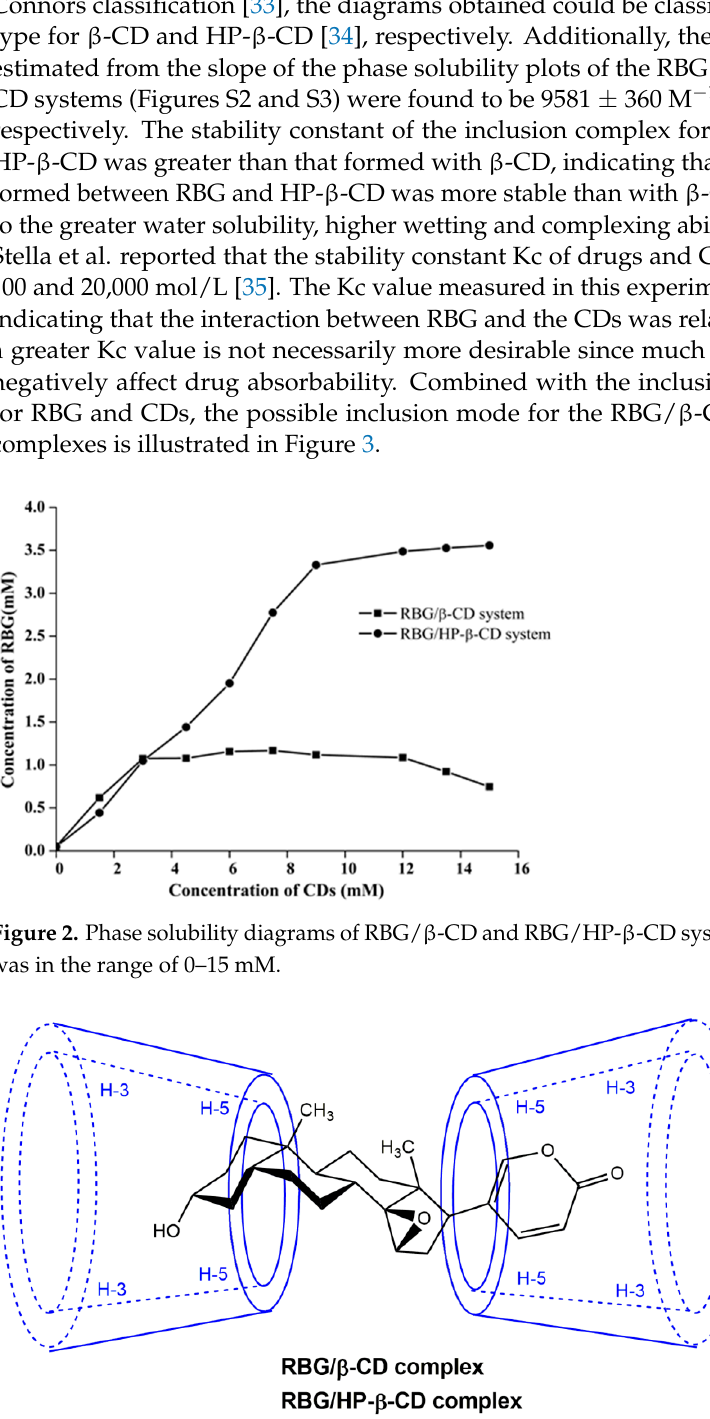
Figure 3. Possible inclusion mode of the inclusion complexes.